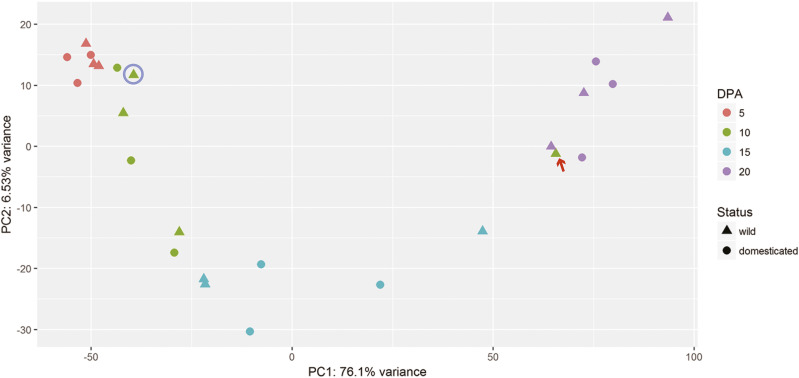
PCA of RNA-seq libraries. PC1, which accounts for more than three quarters of the variance (76.1%), is closely related to developmental stage, which ranges from 5 to 20 days post-anthesis (dpa; key to the right). The red arrow denotes a wild 10 dpa sample that grouped with the 20 dpa samples; this library was excluded from the analyses and replaced by a previously sequenced G. hirsutum var. yucatanense (TX2094) sample (circled).